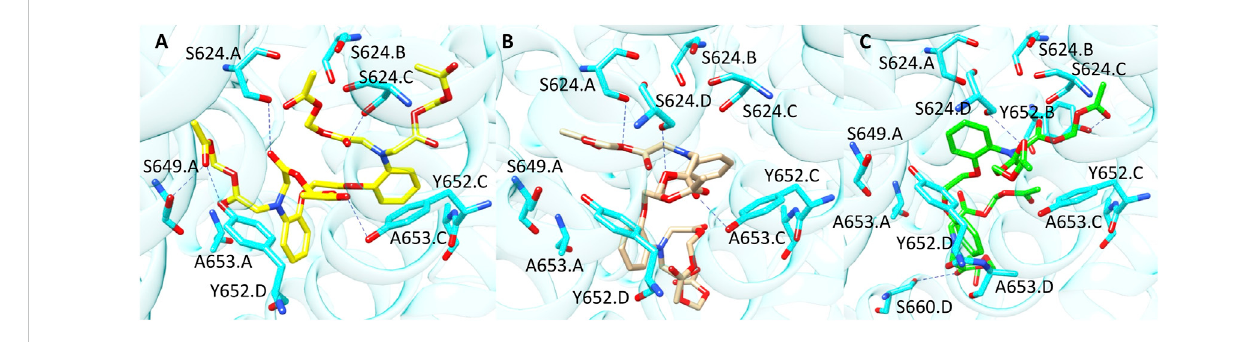
FIGURE 8 Binding modes of compound 10 into hERG binding site predicted by (A) PLANTS, (B) LiGen and (C) GOLD. H-bonds are represented as blue dashed lines.